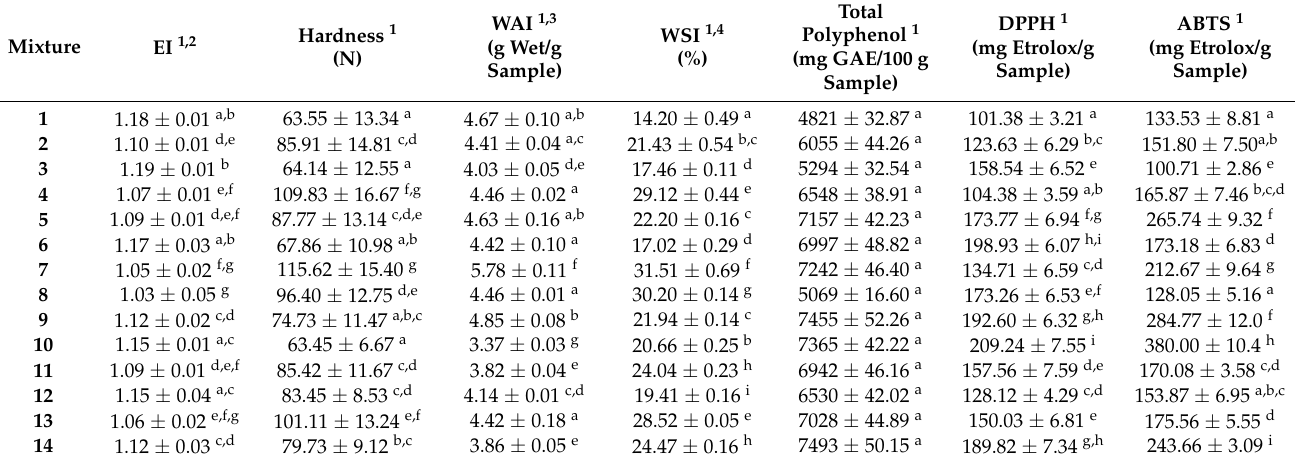
Table 3. Results of the response variables of the mixture design.